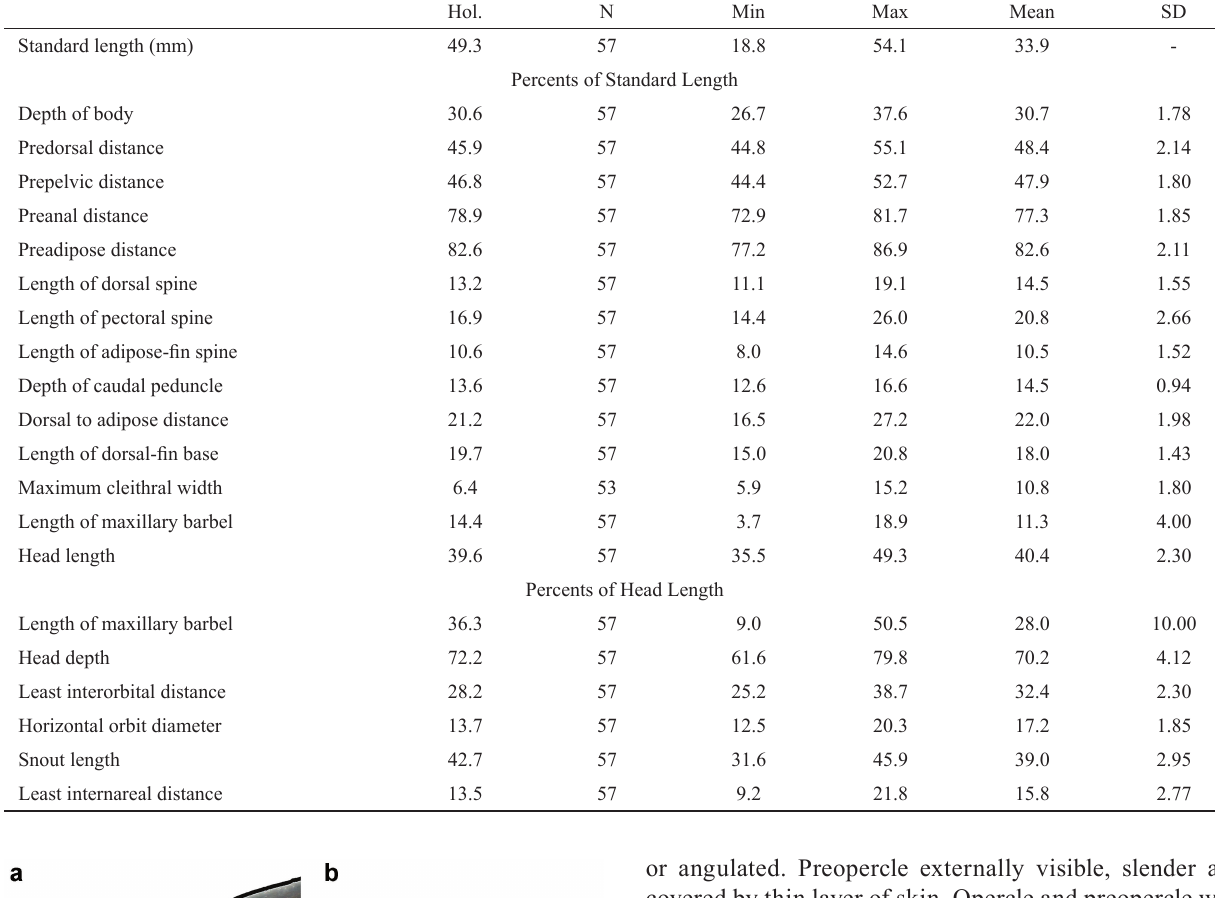
Table 1. Morphometric data of Scleromystax reisi . Range includes holotype and paratypes.